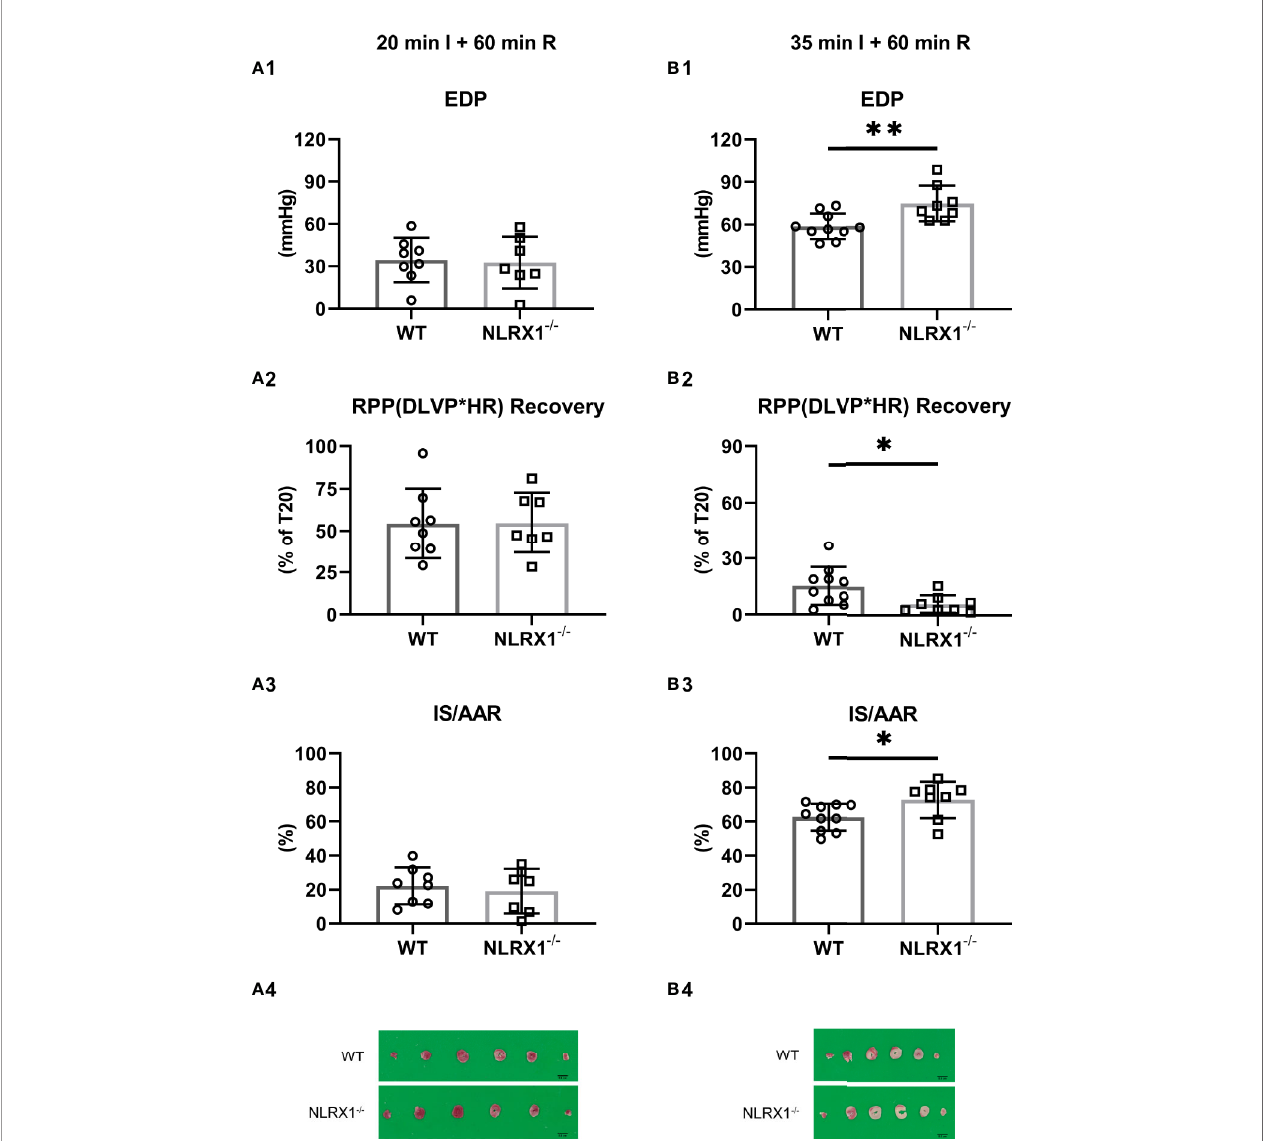
FIGURE 3 | Effects of NLRX1 deletion on mild (A) and severe (B) IR injury in isolated hearts of protocols 1 and 2. All values determined at 60 min reperfusion. (A1/ B1) End diastolic pressure (EDP); (A2/B2) Rate Pressure Product (RPP) recovery; and (A3/B3) Infarct size (IS). DLVP, developed left ventricular pressure; HR, heart rate; AAR, area at risk. Values represent mean ± SD. (n=8/7 per group for (A) ; n=10/8 per group for (B) . * P < 0.05, ** P < 0.01 by t